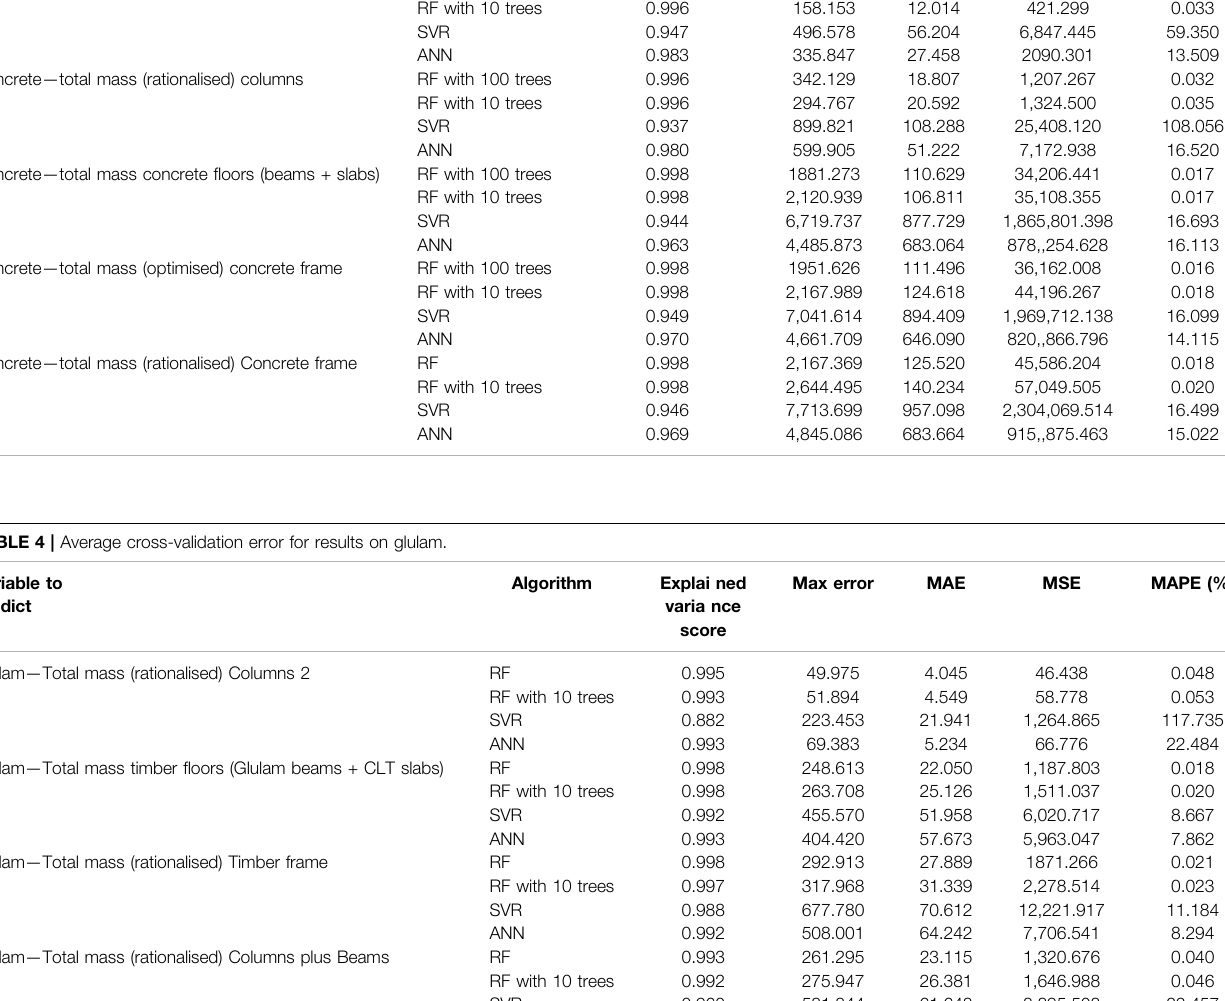
TABLE 3 | Average cross-validation error for results on concrete. Variable to predict Concrete — total mass (optimised) columns